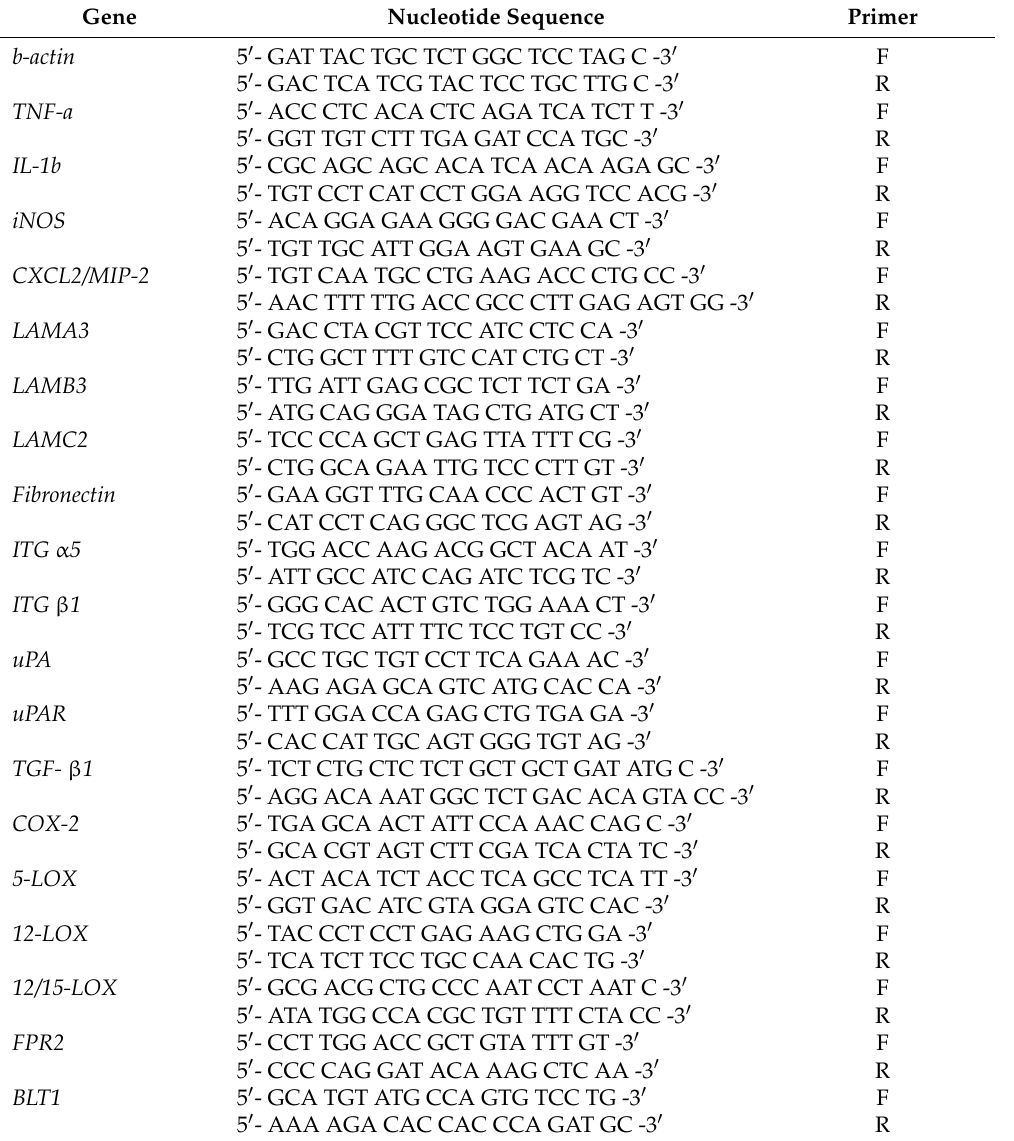
Table 1. Nucleotide sequence of the specific primers used for PCR